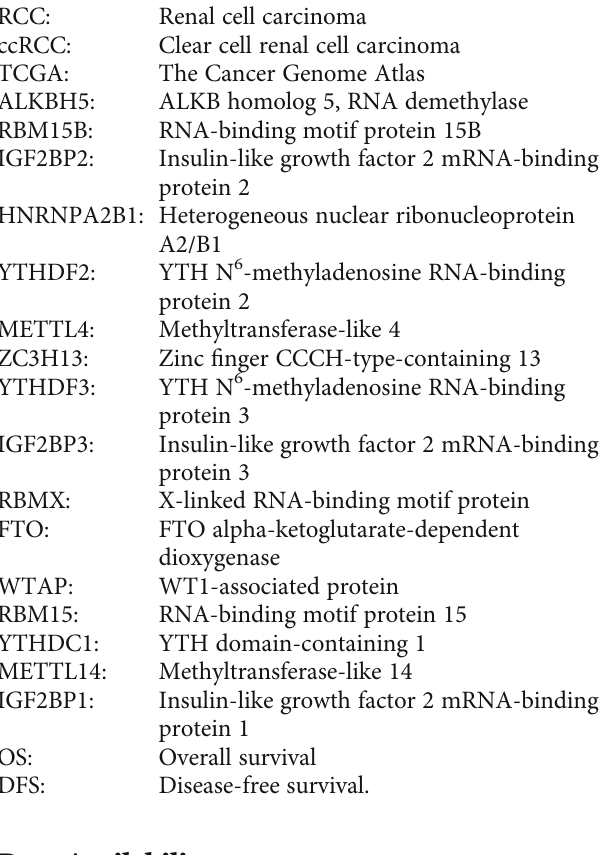
Figure S1: external veri fi cation based on the GSE22541 dataset. Table S1: expression of 18 m 6 A RNA methylation regulators between clusters 1 and 2. (Supplementary